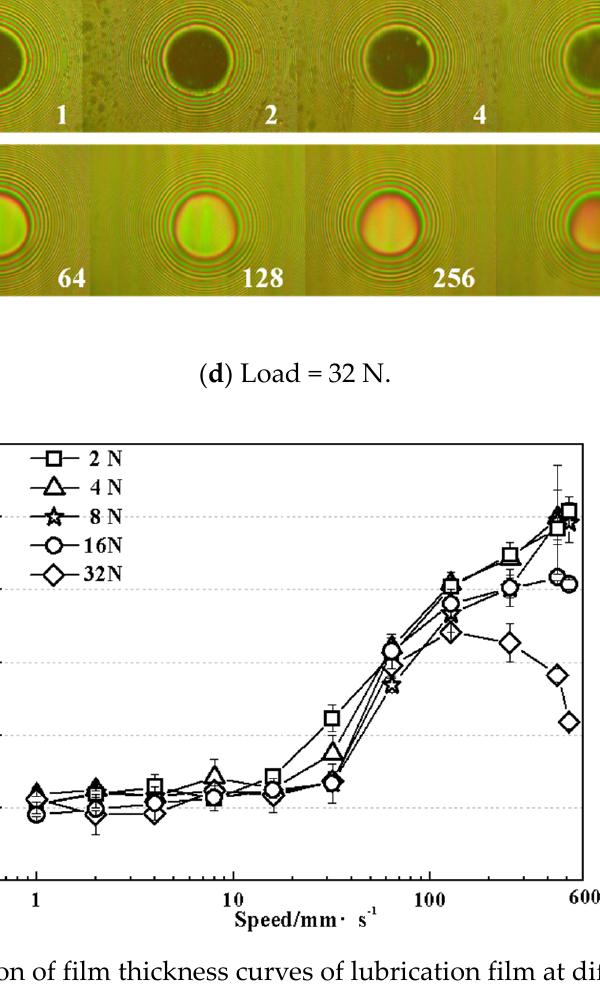
Figure 8. Optical interference images and film thickness curves of polymer brush PSPMA varying with entrainment speeds under different loads: ( a – d ) are the light interference diagrams of 2 N, 8 N, 16 N, and 32 N, respectively, and the film thickness values in ( e ) were obtained from the light interference